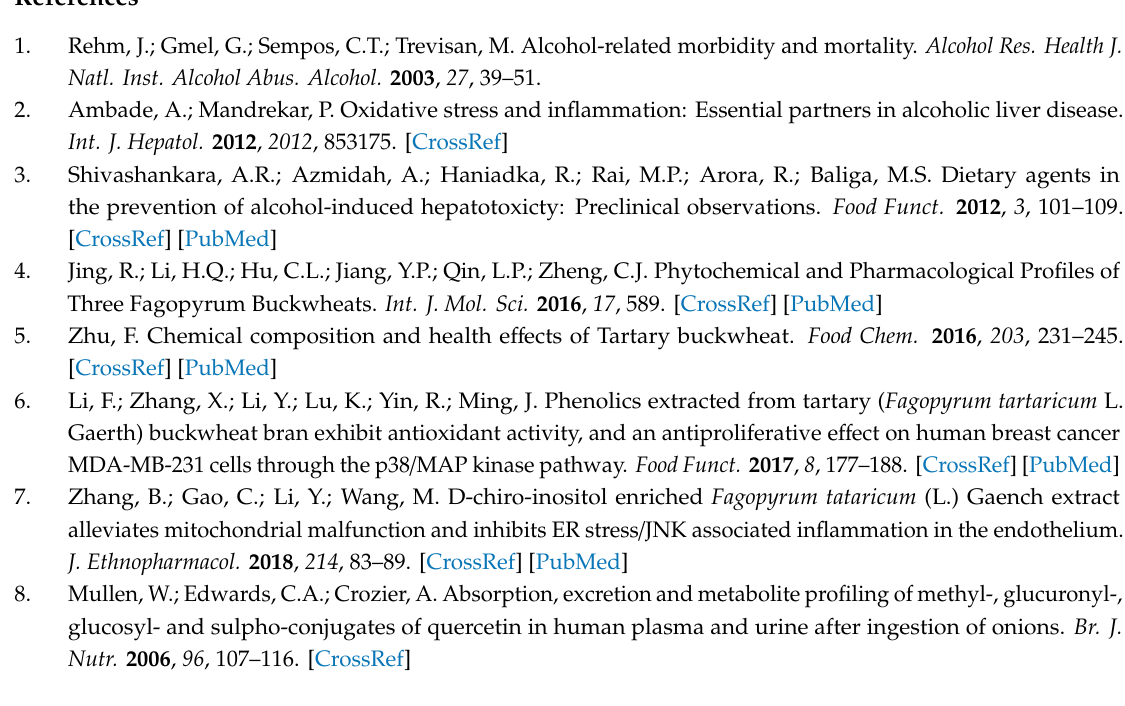
Figure S1: Typical chromatograms of quercetin, kaempferol and d3-quercetin (IS) in dog plasma: (a) blank dog plasma, (b) blank plasma spiked with analytes and IS at LLOQ level, (c) plasma sample obtained from beagle dog after oral administration of tartary buckwheat extract. Figure S2: Fragmentation pathways of quercetin. Table S1: List of ion pair parameters, declustering potential (DP), collision energy (CE), cell exit potential (CXP) for quercetin, kaempferol and d3-quercetin (IS). Table S2: The linearity of quercetin in beagle dog plasma measured by LC-MS / MS. Table S3: The linearity of kaempferol in beagle dog plasma measured by LC-MS / MS. Table S4: Intra-day and inter-day accuracy and precision of quercetin at all QC levels. Table S5: Intra-day and inter-day accuracy and precision of kaempferol at all QC level. Table S6: Matrix e ff ect and extraction recovery of quercetin, kaempferol and IS in dog plasma at three QC levels ( n = 6). Table S7: The dilution reliability of quercetin and kaempferol. Table S8: Stability of quercetin in dog plasma under various conditions. Table S9: Stability of kaempferol in dog plasma under various